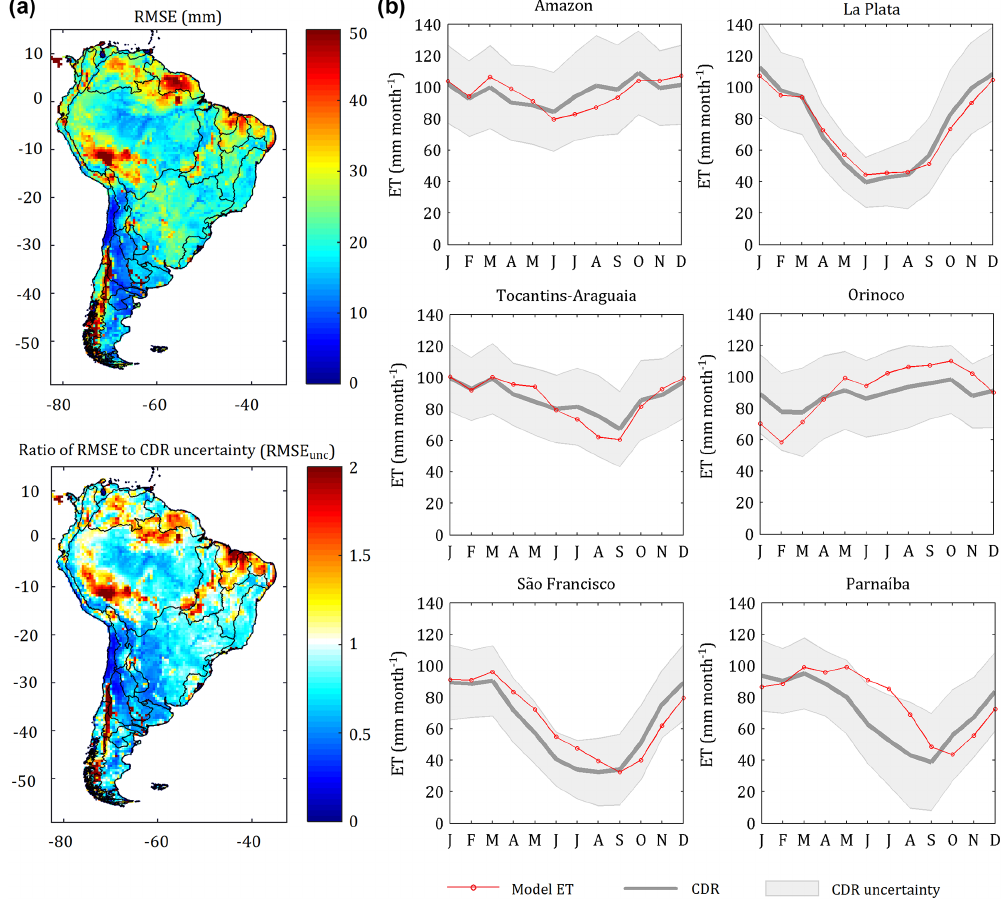
Figure 7. Comparison between MGB and CDR ET estimates in terms of RMSE (a) and seasonality for major South American basins (b) . The light gray area represents the proxy of the CDR uncertainty, i.e., the mean deviation of all datasets (within CDR) from the ensemble mean (Zhang et al.,